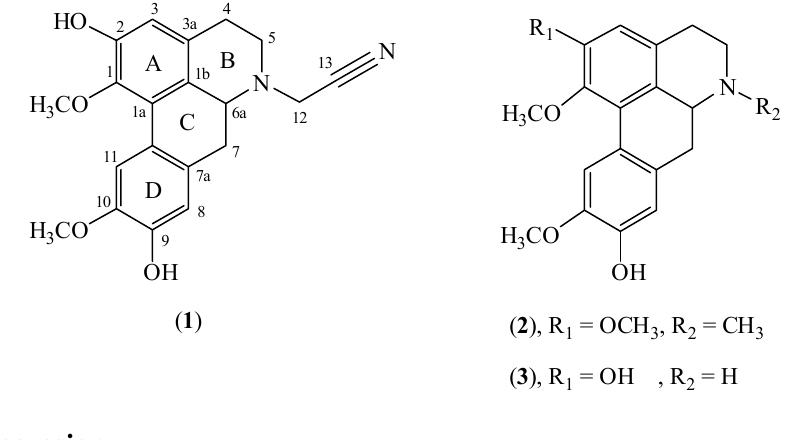
Figure 1. Alkaloids 1 - 3 isolated from Alseodaphne perakensis .